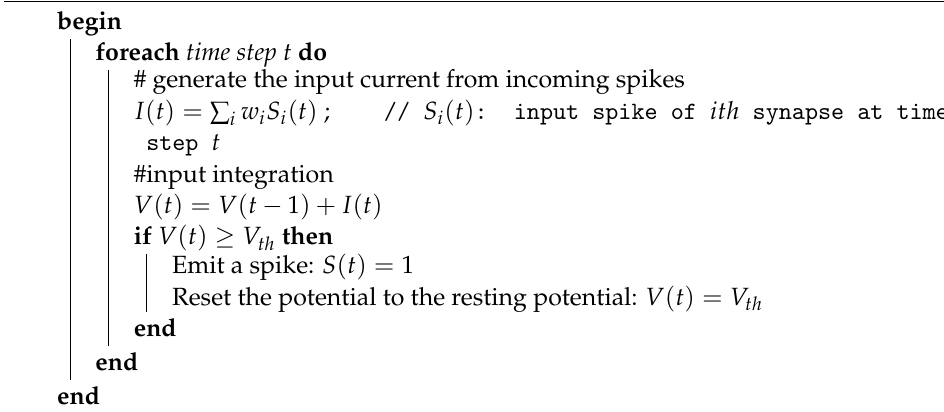
Algorithm A1: Behavior of the IF neuron model.